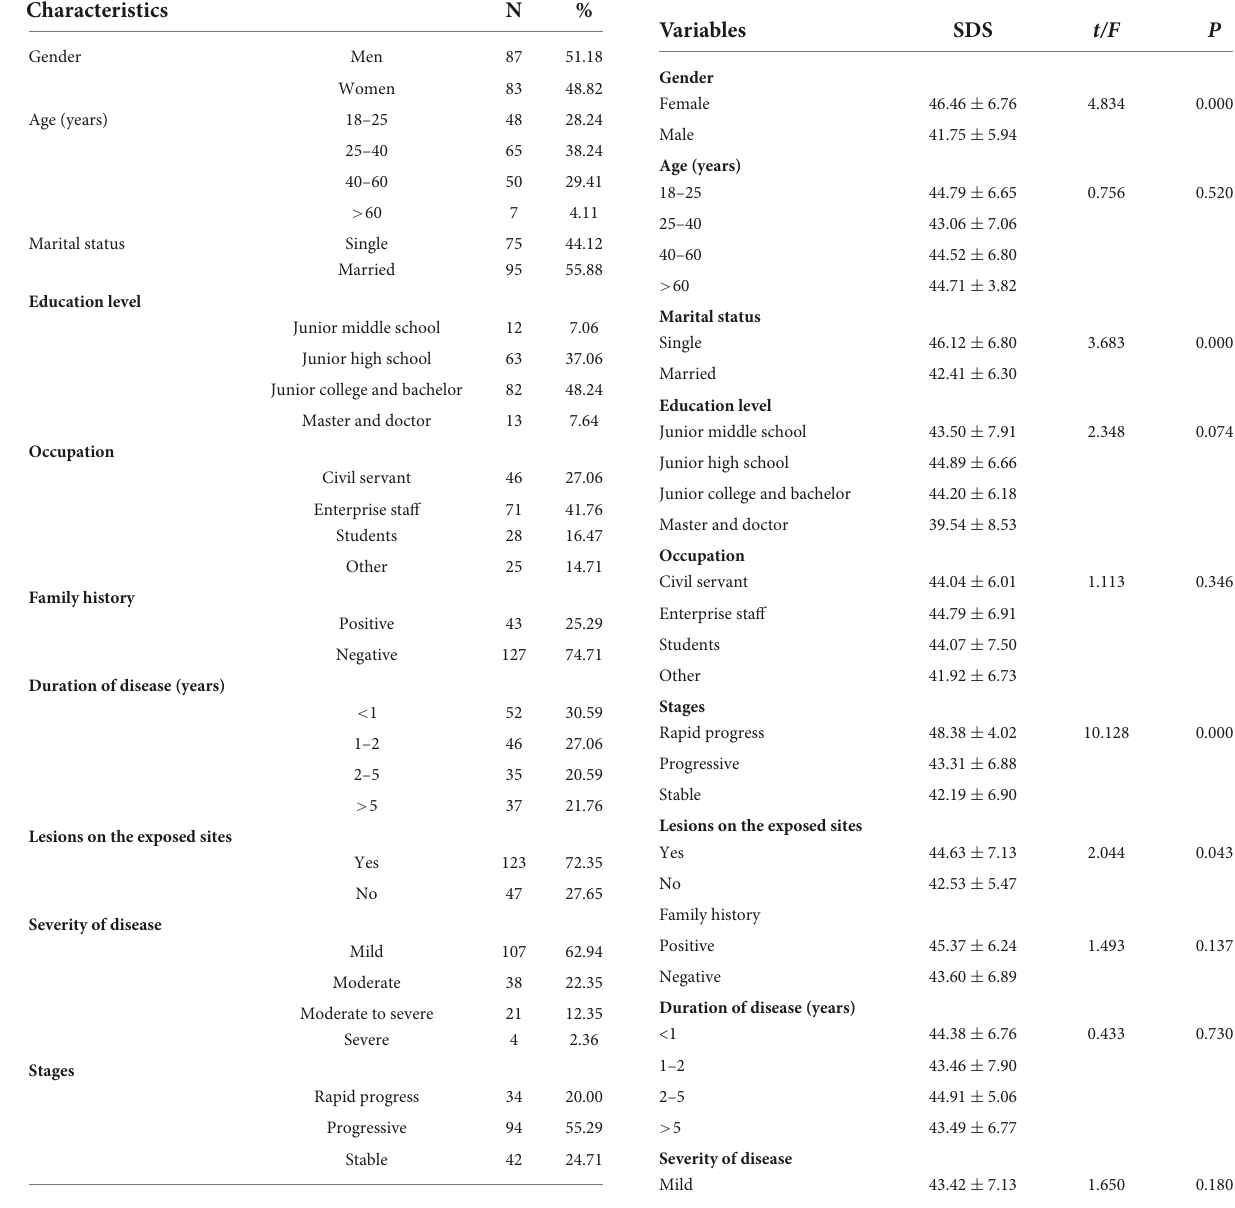
TABLE 2 Univariate analysis of patients with vitiligo in the score of SDS (mean ±